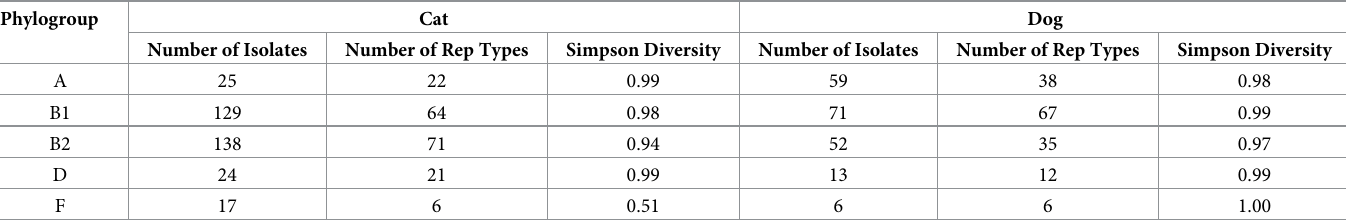
Table 3. E . coli genotype (REP = types) richness and diversity of E . coli isolated from cats and dogs with respect to the phylogroup membership of the isolate.